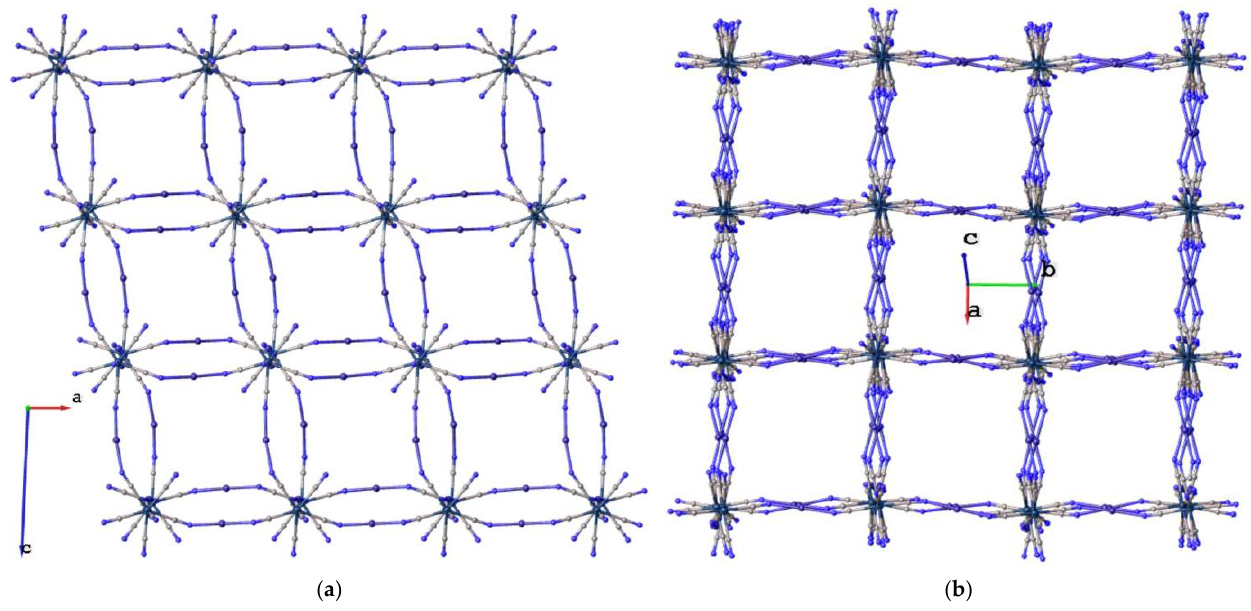
Figure 6. Different views for the structure of 11 : ( a ) along the b axis (010); ( b ) projection on the 101 plane.